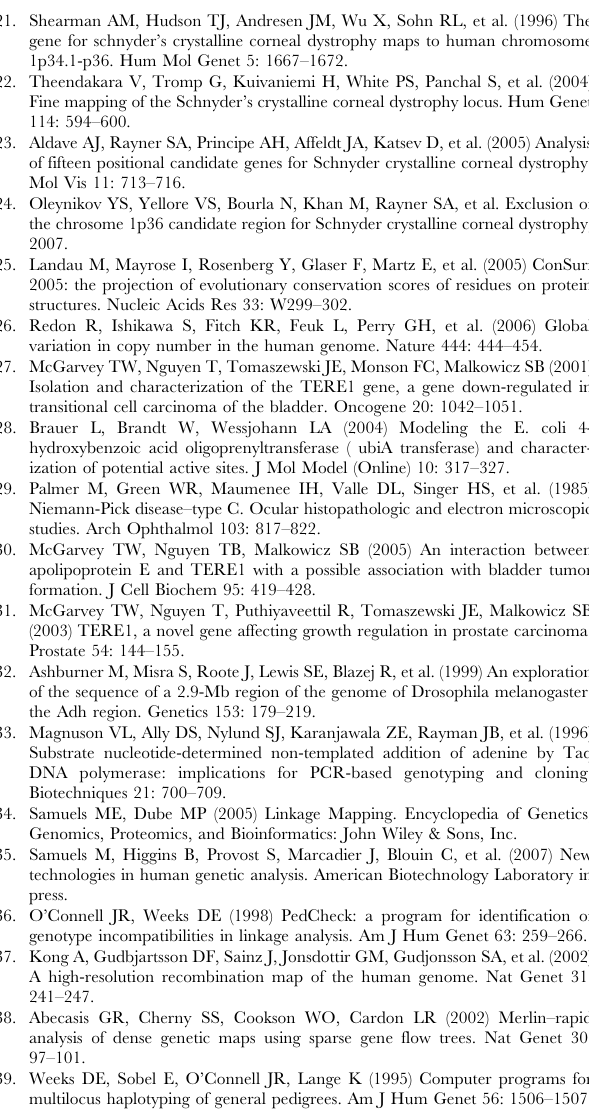
Figure S3 Multiple sequence alignment of distant orthologs